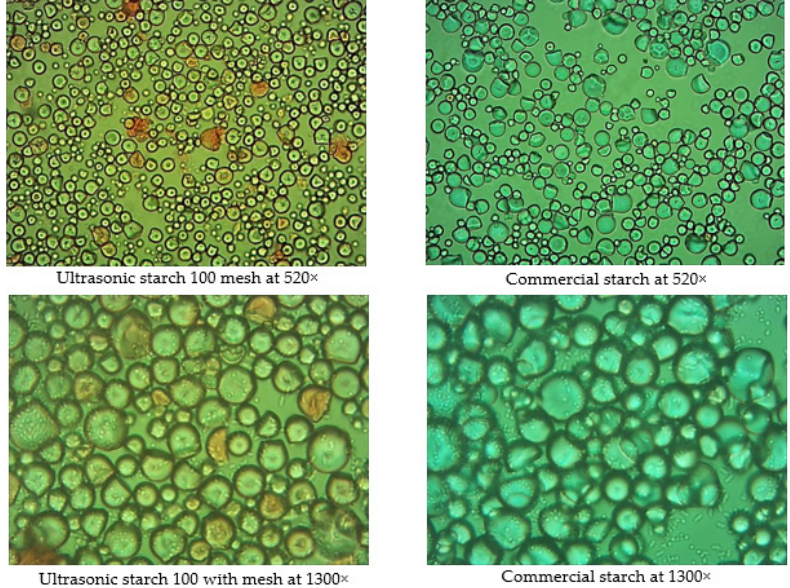
Figure 6. The shape of starch granules observed for ultrasound-produced starch and commercial sample.